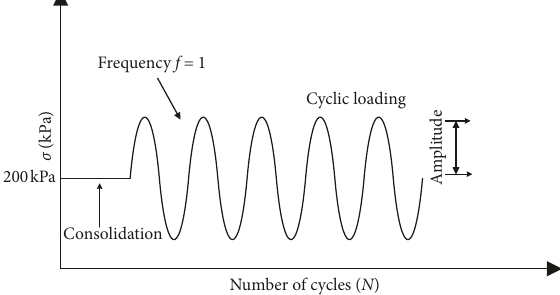
Figure 7: Loading pattern in the cyclic triaxial